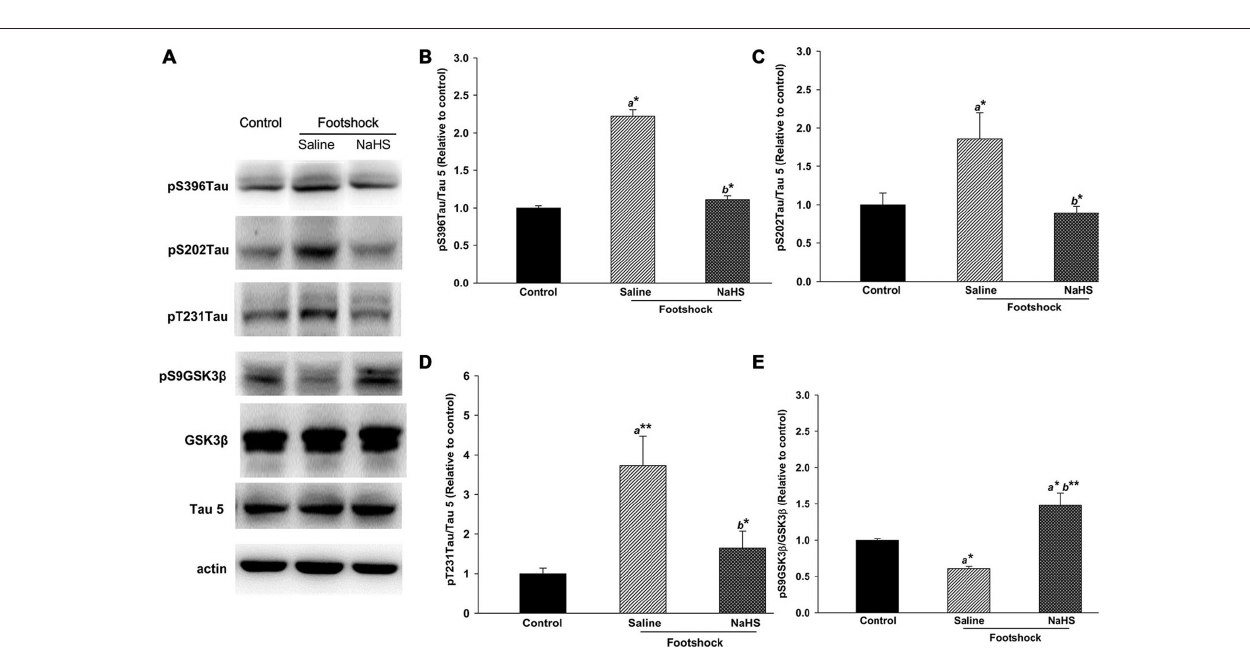
FIGURE 8 | NaHS decreased the levels of various forms of phosphorylated tau protein and increased the level of pS9GSK3 β in the hippocampus of mice under footshock. Representative Western blots (A) and densitometry for phosphorylated tau (Ser396; B ), (Ser202; C ), and (Thr231; D ) as well as the pS9GSK3 β /GSK3 β ratio (E). Tau 5 was used for total tau, with β -actin as the internal control. The quantitative data are the mean ± SEM of each group ( n = 3–5 per group). ∗ p < 0.05; ∗∗ p < 0.01. a , compared to the control group. b , compared to the footshock/saline group.